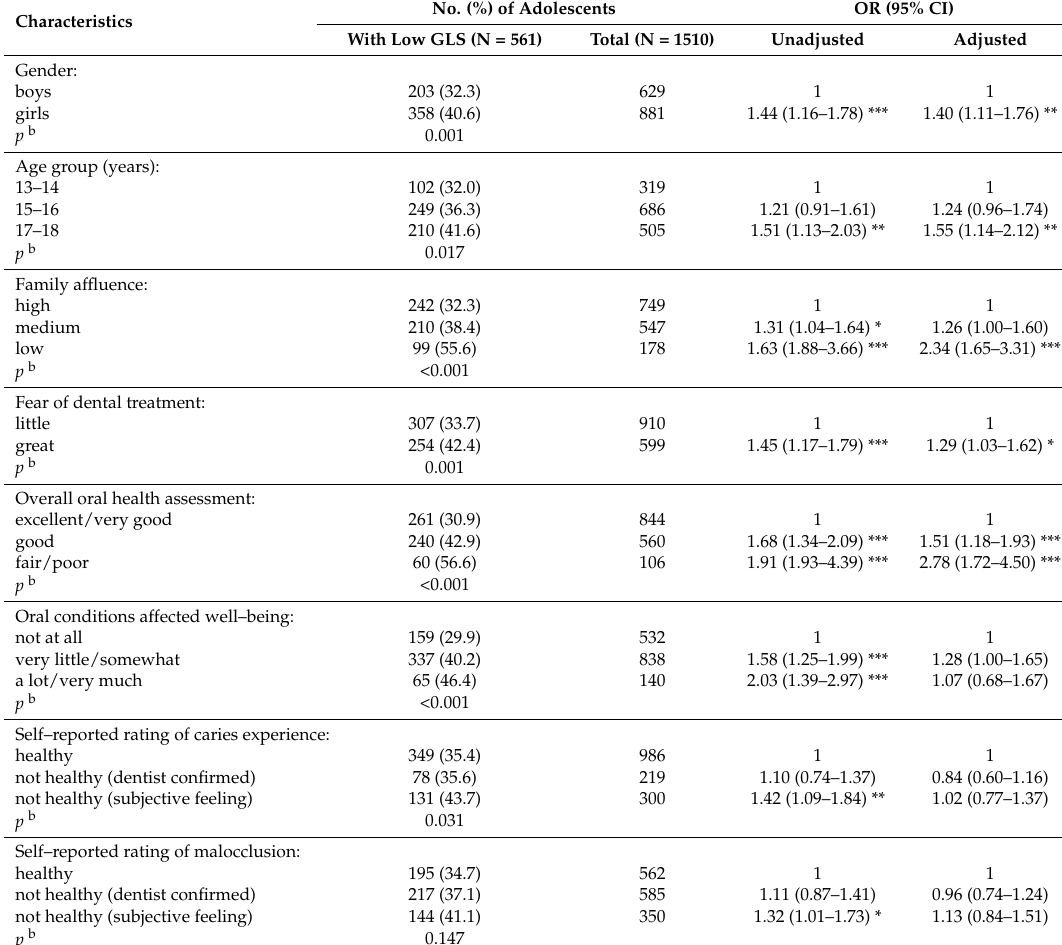
Table 2. Prevalence of low global life satisfaction and its odds in a sample of adolescents in Lithuania a .